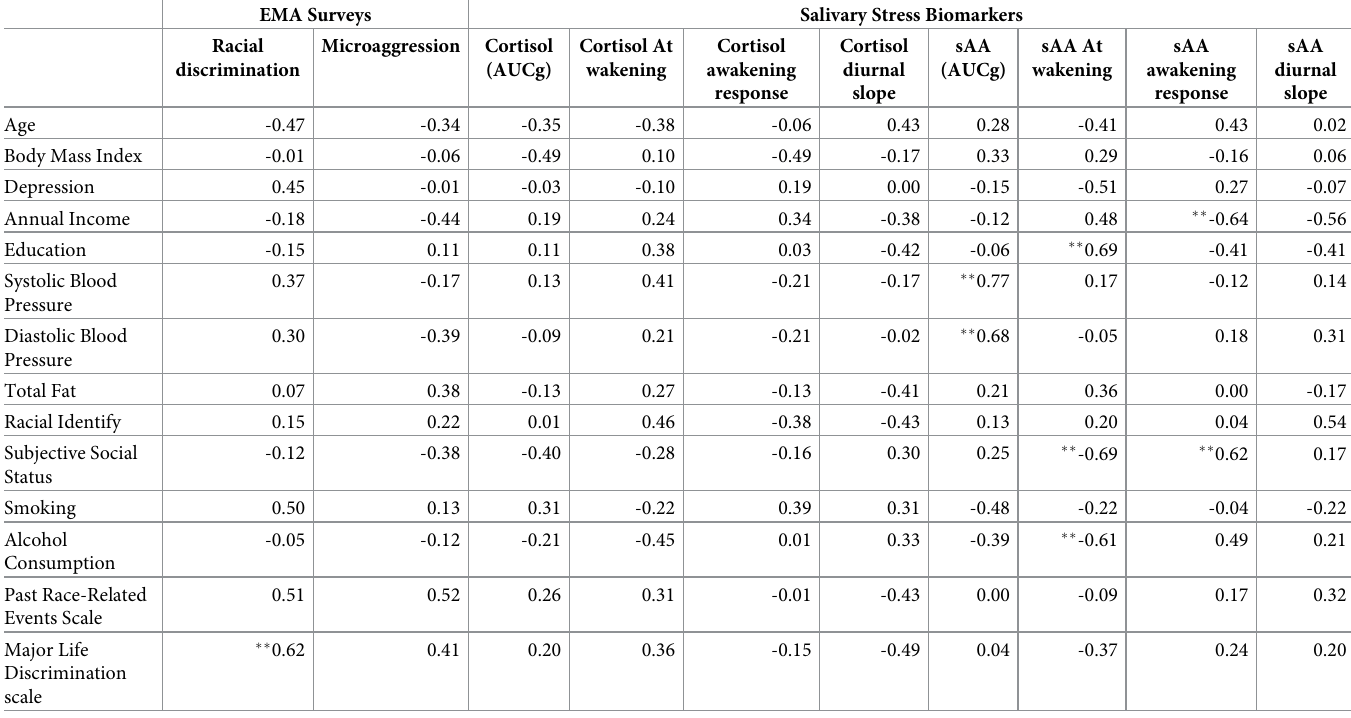
Table 2. Spearman correlations among baseline characteristics, average scores of the EMA survey, and salivary stress biomarkers (n = 12).